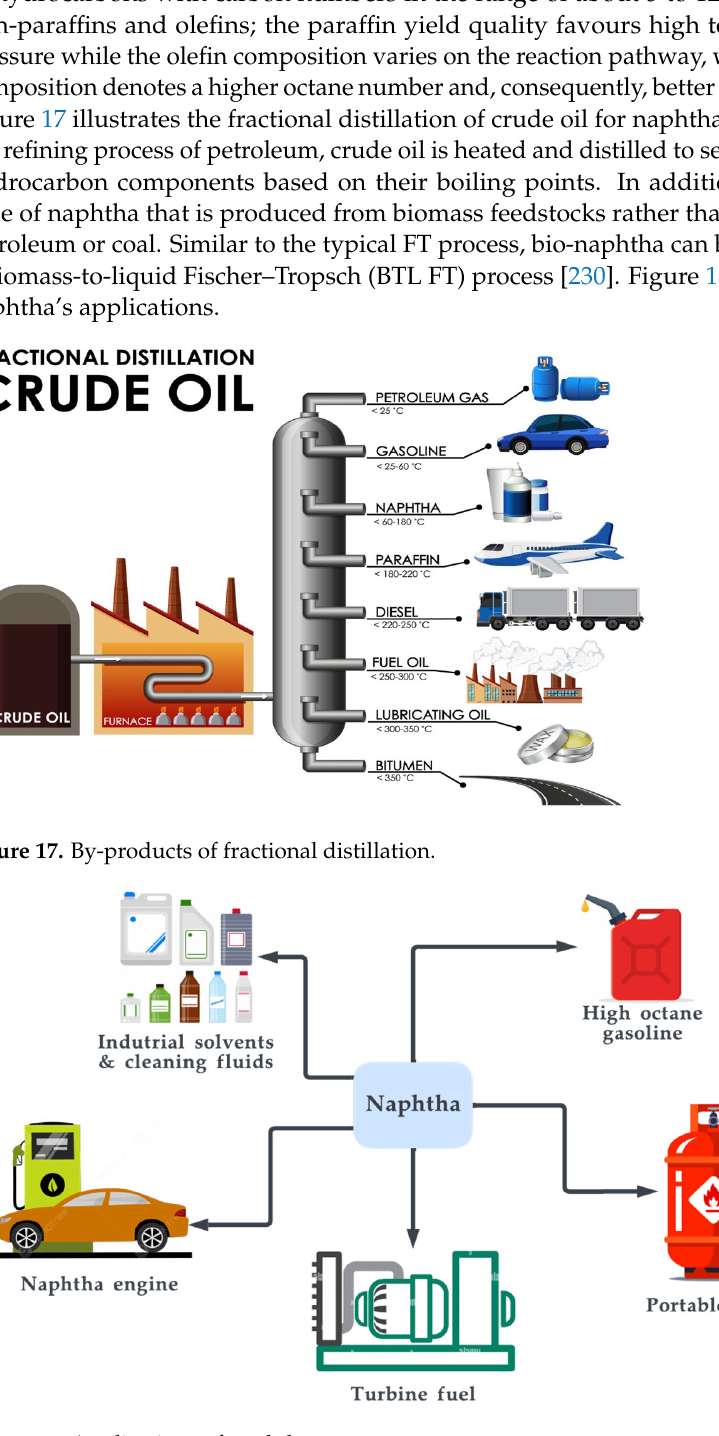
Figure 18. Applications of